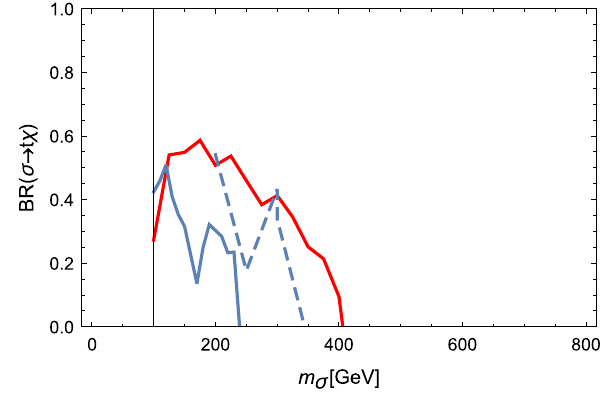
Fig. 2 Lower bound on BR t χ as a function of the mass of m σ extracted from the search for a pair of dijet resonances in LHC proton-proton √ s = 8 TeV (dashed) and 13 TeV (solid), and data by CMS (blue) at √ s = 13 TeV. The area under the curves by ATLAS (solid red) for is the excluded region. For the Run 1 CMS search, the discontinuity at m σ = 300 GeV stems from the transition between two different search strategies respectively targeting low-mass and high-mass reso- nances